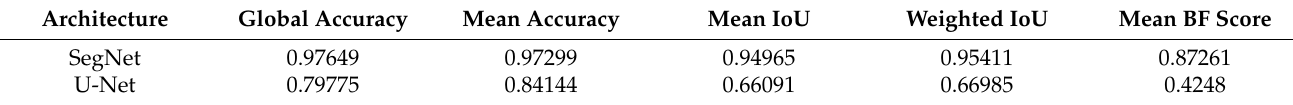
Table 2. Accuracy metrics for both trained